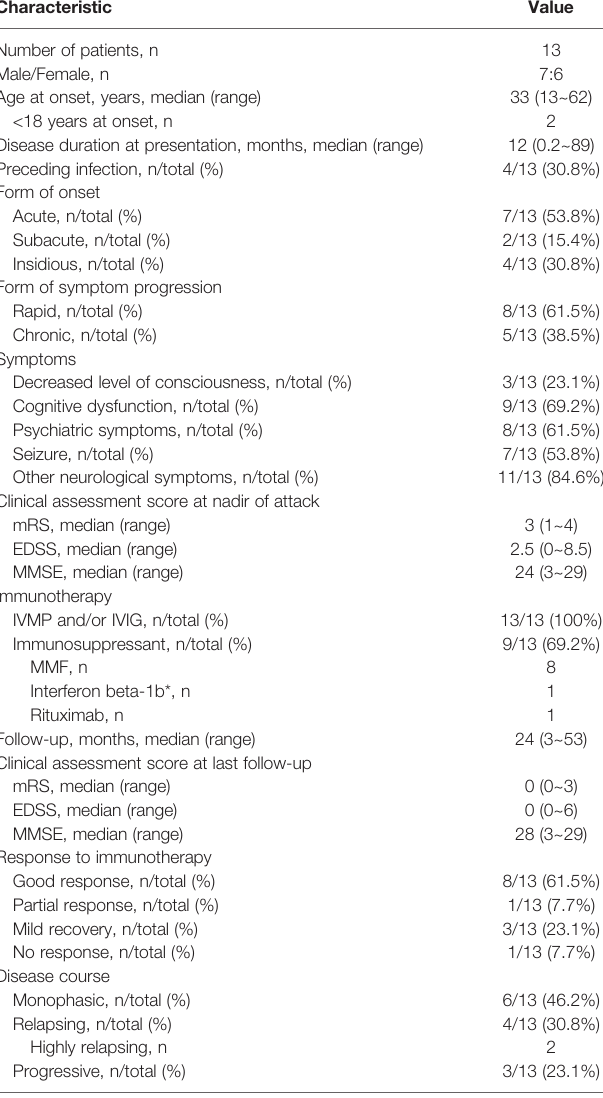
TABLE 1 | Demographic, clinical, treatment and follow-up data in 13 patients with MOG-E. Characteristic Value Number of patients,